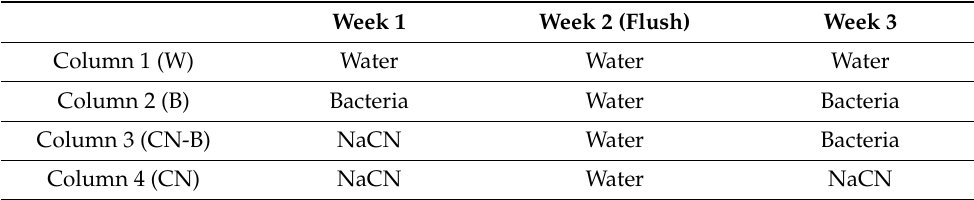
Table 1. Treatment schedule for leaching